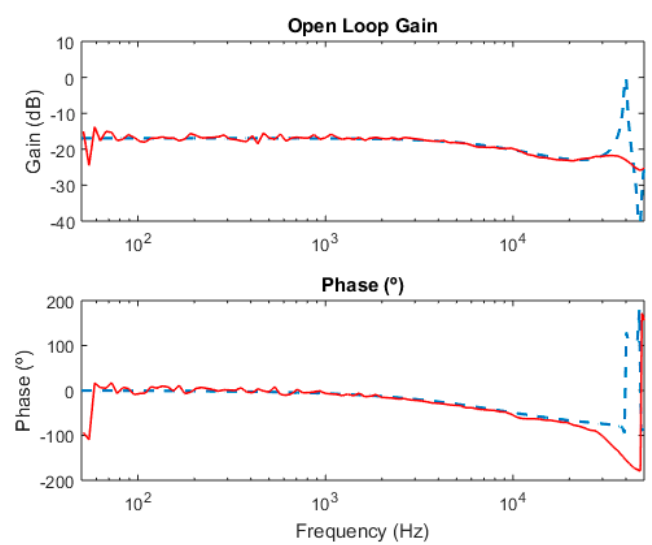
Figure 16. Experimental (solid red line) and predicted by the proposed model (dashed blue line) AC response of the converter.